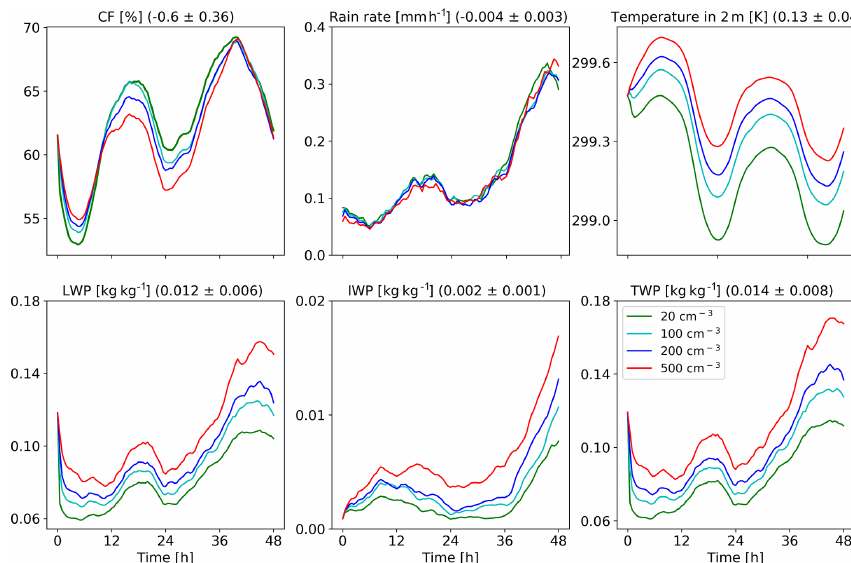
Figure 8. Domain-average properties as a function of time for the different CDNC simulations for the shallow-cloud-dominated case. The properties that are presented here are cloud fraction (CF), rain rate, temperature in 2m, liquid water path (LWP – based on the cloud water mass, excluding the rain mass for consistency with satellite observations), ice water path (IWP) and total water path (TPW = LWP + IWP). For each property, the mean difference between all combinations of simulations, normalized to an increase in CDNC by a factor of 5, and its standard deviation appear in brackets.